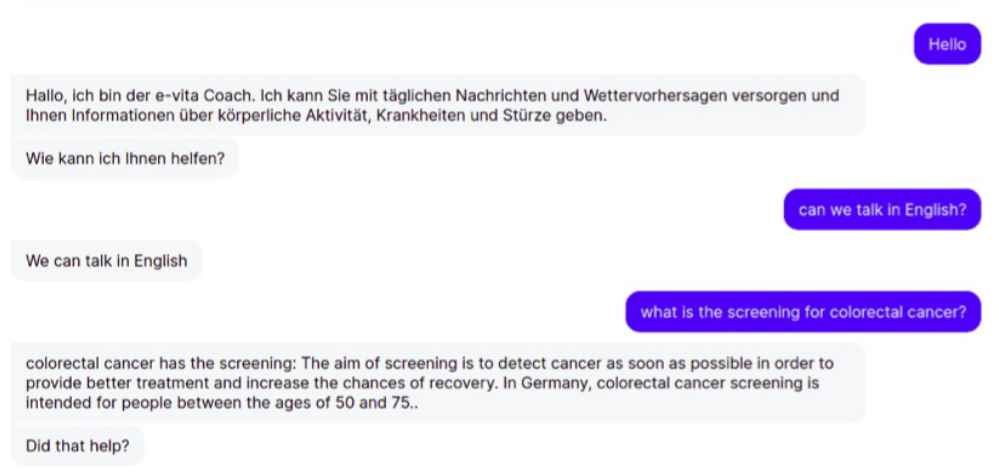
Figure 8. Example of the virtual coach switching